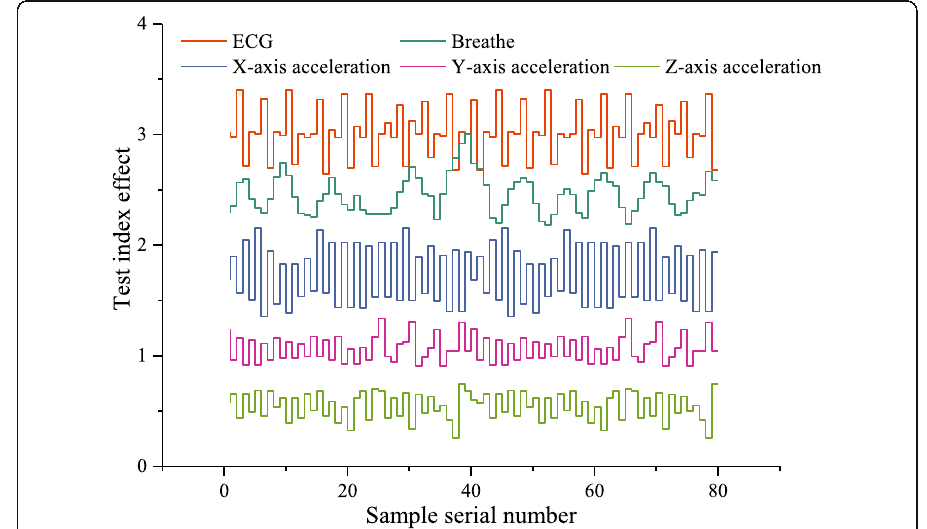
Fig. 7 Test values of cardiopulmonary physiological signals — exercise intensity 8